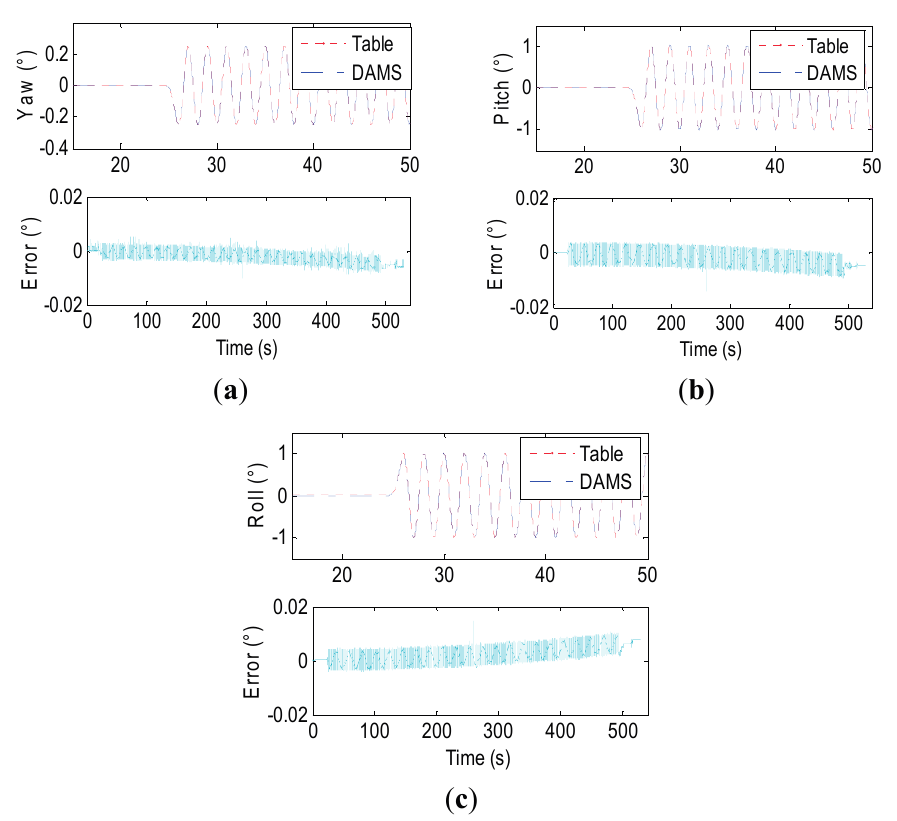
Figure 20. Three axes wobbling test process and error curve (2 Hz).